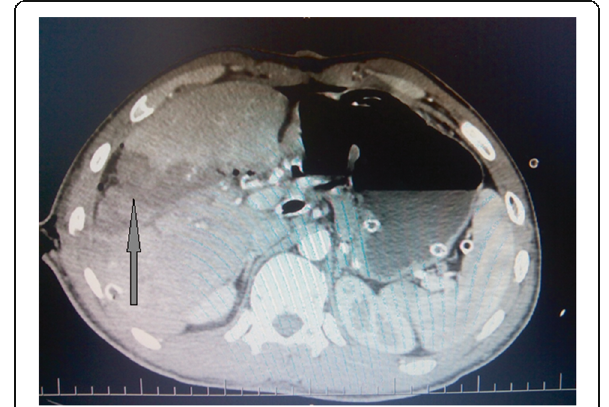
Fig. 2 Demonstration of liver damage (second day after injury): damaged tissues were sutured and omentopexy was applied (marked by the arrow)